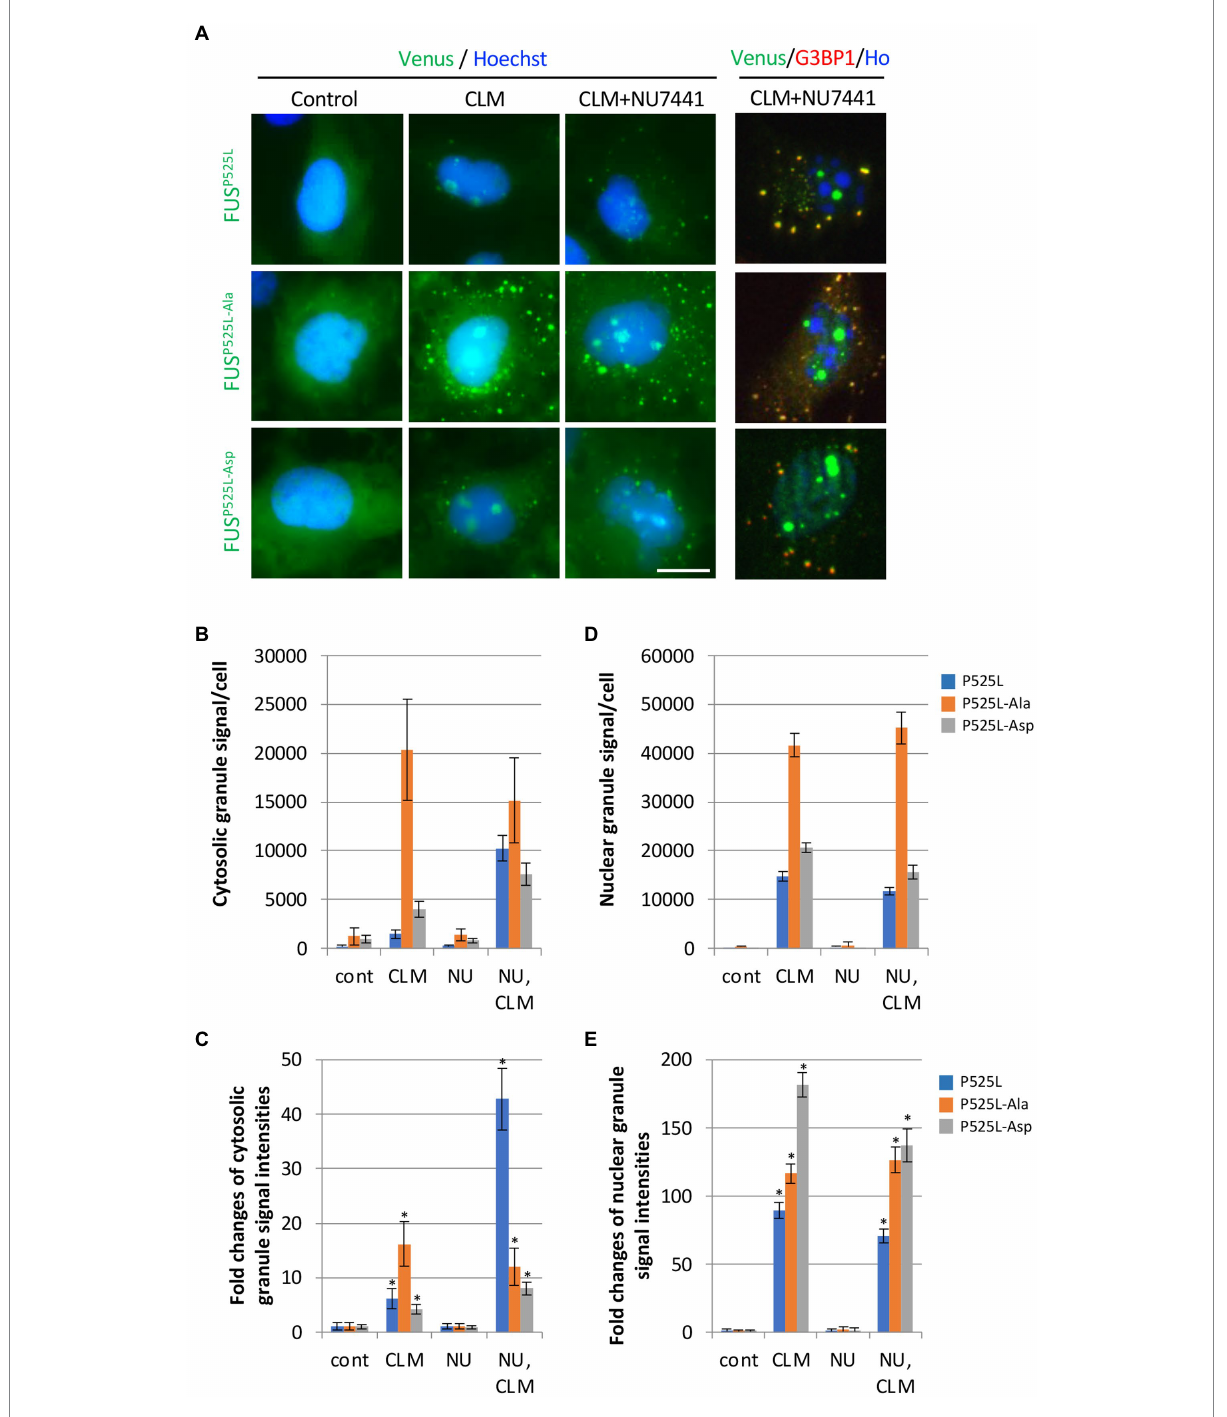
FIGURE 4 Synergistic effect of replacing 12 S/TQ residues with AQ or DQ residues in the N-terminal region of FUS P525L on SG formation during CLM/NU7441 stimulation. (A) The subcellular distribution of Venus-FUS P525L , Venus-FUS P525L-Ala, and Venus-FUS P525L-Asp proteins co-stained with G3BP1 (Red), a marker for SGs and Hoechst (Blue), a marker for nuclei was observed by fluorescence microscopy. Cells were pretreated with 1 μ M NU7441 and were then treated with 100 nM CLM in the presence of 1 μ M NU7441 or DMSO (control) for 5 h. Scale bar: 20 μ m. (B,C) Quantification of Venus fluorescence signals at cytosolic granules and fold changes of their signals to each control of Venus-FUS P525L , Venus-FUS P525L-Ala and Venus-FUS P525L- Asp with the IN Cell Analyzer imaging system. The result of statistical analysis is shown in Supplementary Table 1. (D,E) Quantification of Venus fluorescence signals at nuclear granules and fold changes of their signals to each control of Venus-FUS P525L , Venus-FUS P525L-Ala and Venus-FUS P525L- Asp with the IN Cell Analyzer imaging system. Asterisk indicates significant change relative to FUS derivates-SGs containing cells of DMSO control with CLM + NU7441 treatment ( t -test p < 0.001). The result of statistical analysis is also shown in Supplementary Table